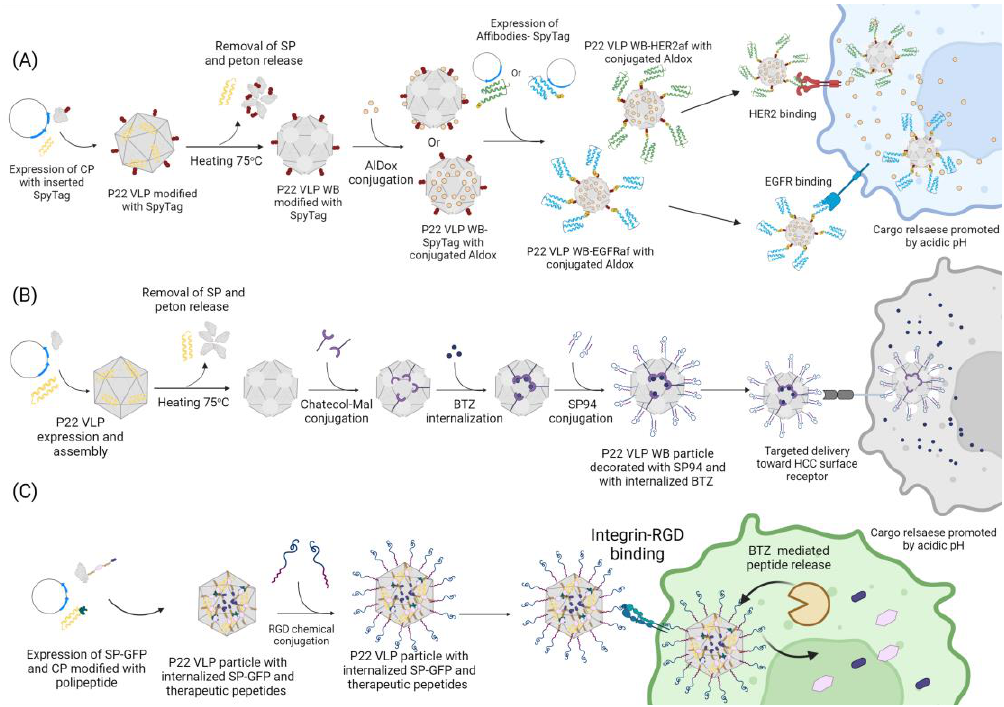
Figure 7. Targeted delivery of cargo. The scheme illustrates some examples of the reported methods for the targeted cargo delivery and release inside the cell. ( A ) The expression of CP subunits containing the inserted SpyTag allows for the decoration of the P22 VLP WB particles with large molecules, such as affibodies for EGFR (EGFRaf) and HER2 (HER2af) modified with the SpyCatcher sequence. These modifications allow for the targeted delivery of Aldoxorubicin (AlDox), which can be bound to the WB particle interior/exterior surface through thiol-maleimide coupling with inserted cysteine residues (S133C or K118C, respectively). The ligands will interact with the particle’s specific receptor, promoting the particle’s endocytosis, and once inside the cell , the acidic pH will promote the c leaving of AlDox’s hydrazine crosslink between Dox and its maleimide moiety , re- sulting in the drug ’ s release [12]. ( B ) Another pH-dependent release strategy involves the use of a catechol-mal ligand to incorporate BTZ into P22 WB particles and release the dipeptide when sub- mitted to low-pH conditions. After BTZ internalization, the loaded P22 WB particles were chemi- cally modified with the peptide SP94 to HCCs, as the ligand binds to surface receptors of the tumoral cells. After internalization, the acid – diol complex that formed between BTZ’s boronic acid and cat- echol- mal’s maleimide moieties is undone, resulting in the release of the drug inside the cell [9]. ( C ) Other methods for the environmentally triggered release of cargo can exploit enzymes to propitiate drug exit, one example using the lysosomal cysteine CTB to promote the release of peptide cargo from within the P22 VLP after endocytosis. The NuBCP-9 and the KLAK therapeutic peptides were encapsulated in vivo into the P22 VLP by being inserted into the N-terminus of CP subunits and coexpressed with SP-EGFP fusion. The peptides were incorporated in an intermittent way with CP, and both therapeutic peptides were intercalated with linker sequences that can be cleaved by CTB.